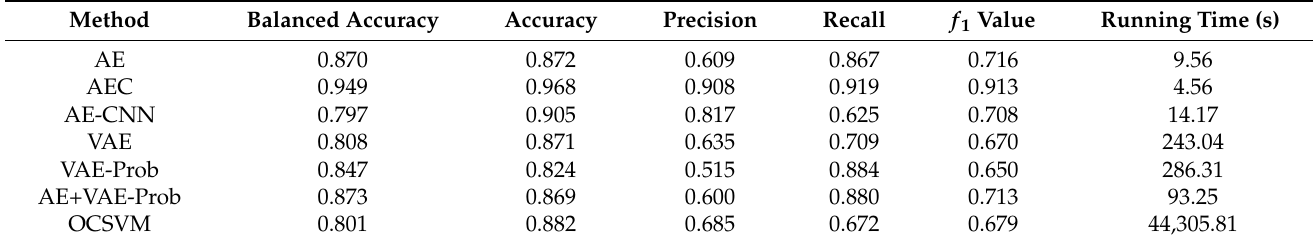
Table 6. Results for the detection of anomalies in the independent test